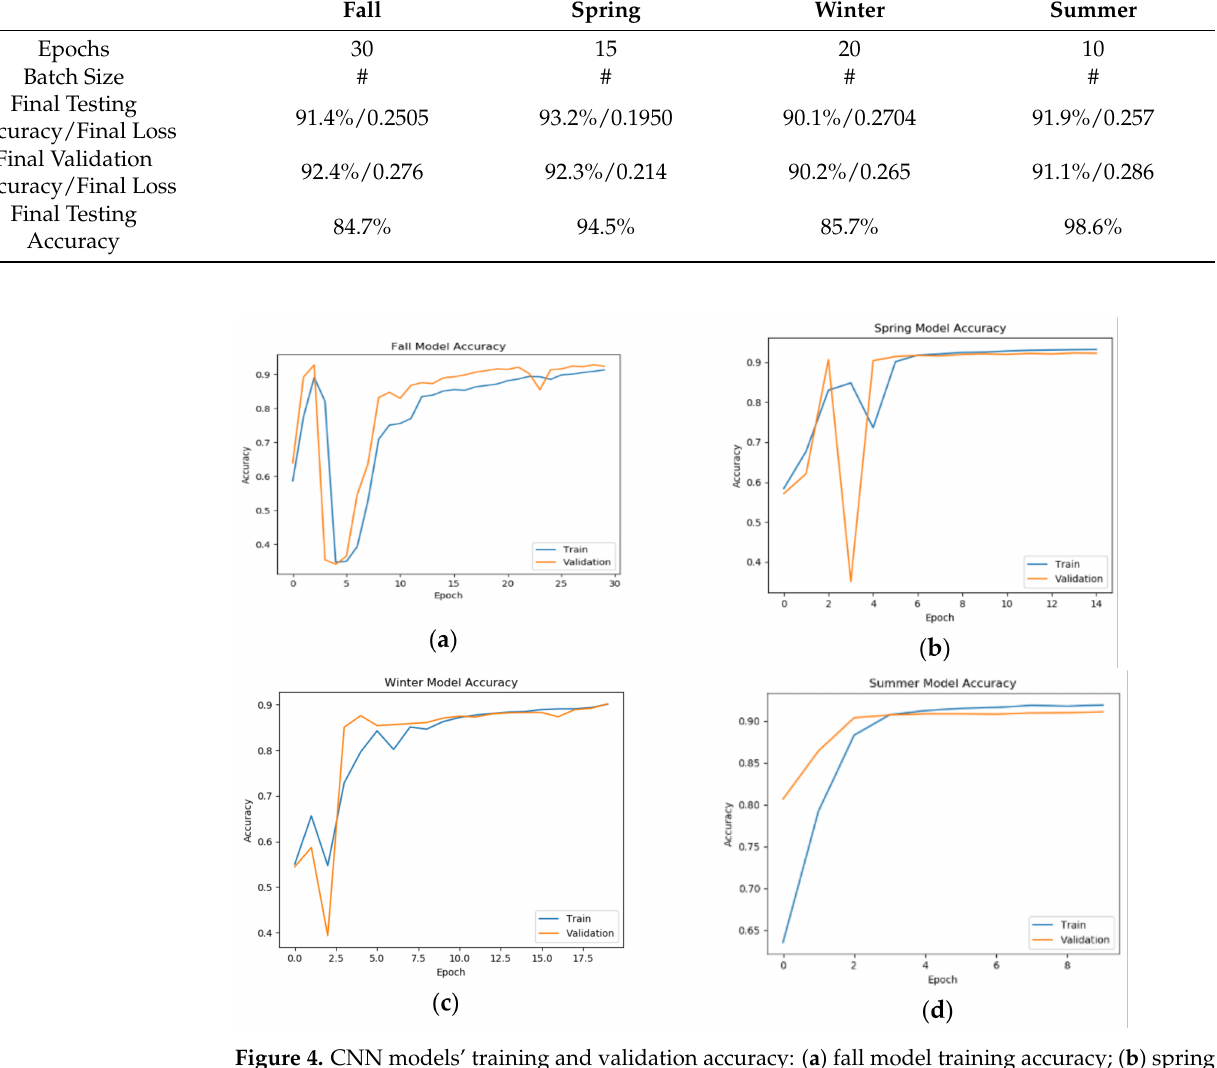
Figure 4. CNN models’ training and validation accuracy: ( a ) fall model training accuracy; ( b ) spring model training accuracy; ( c ) winter model training accuracy; ( d ) summer model training